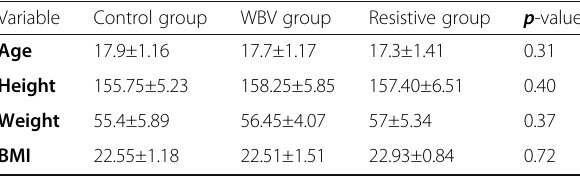
Table 1 Baseline characteristics of the participants in all groups